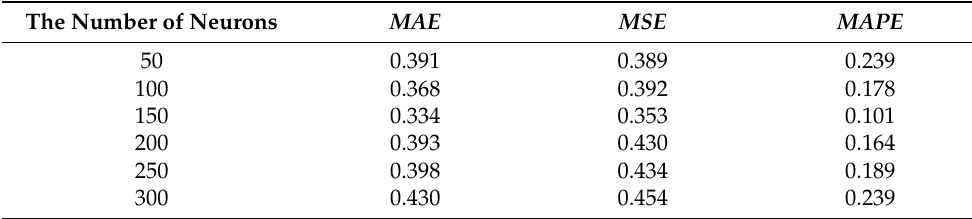
Table 4. Performance of the model with the different number of neurons.